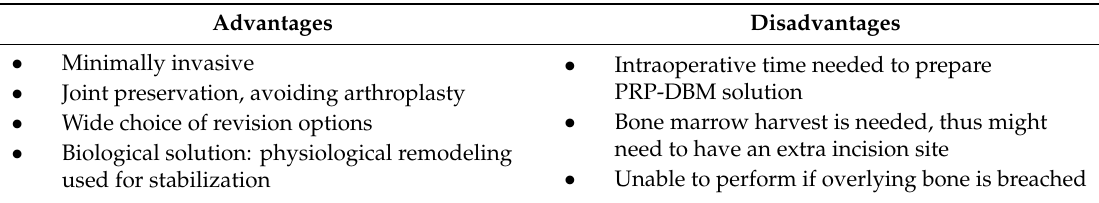
Table 2. Advantages and Disadvantages of IOBP.